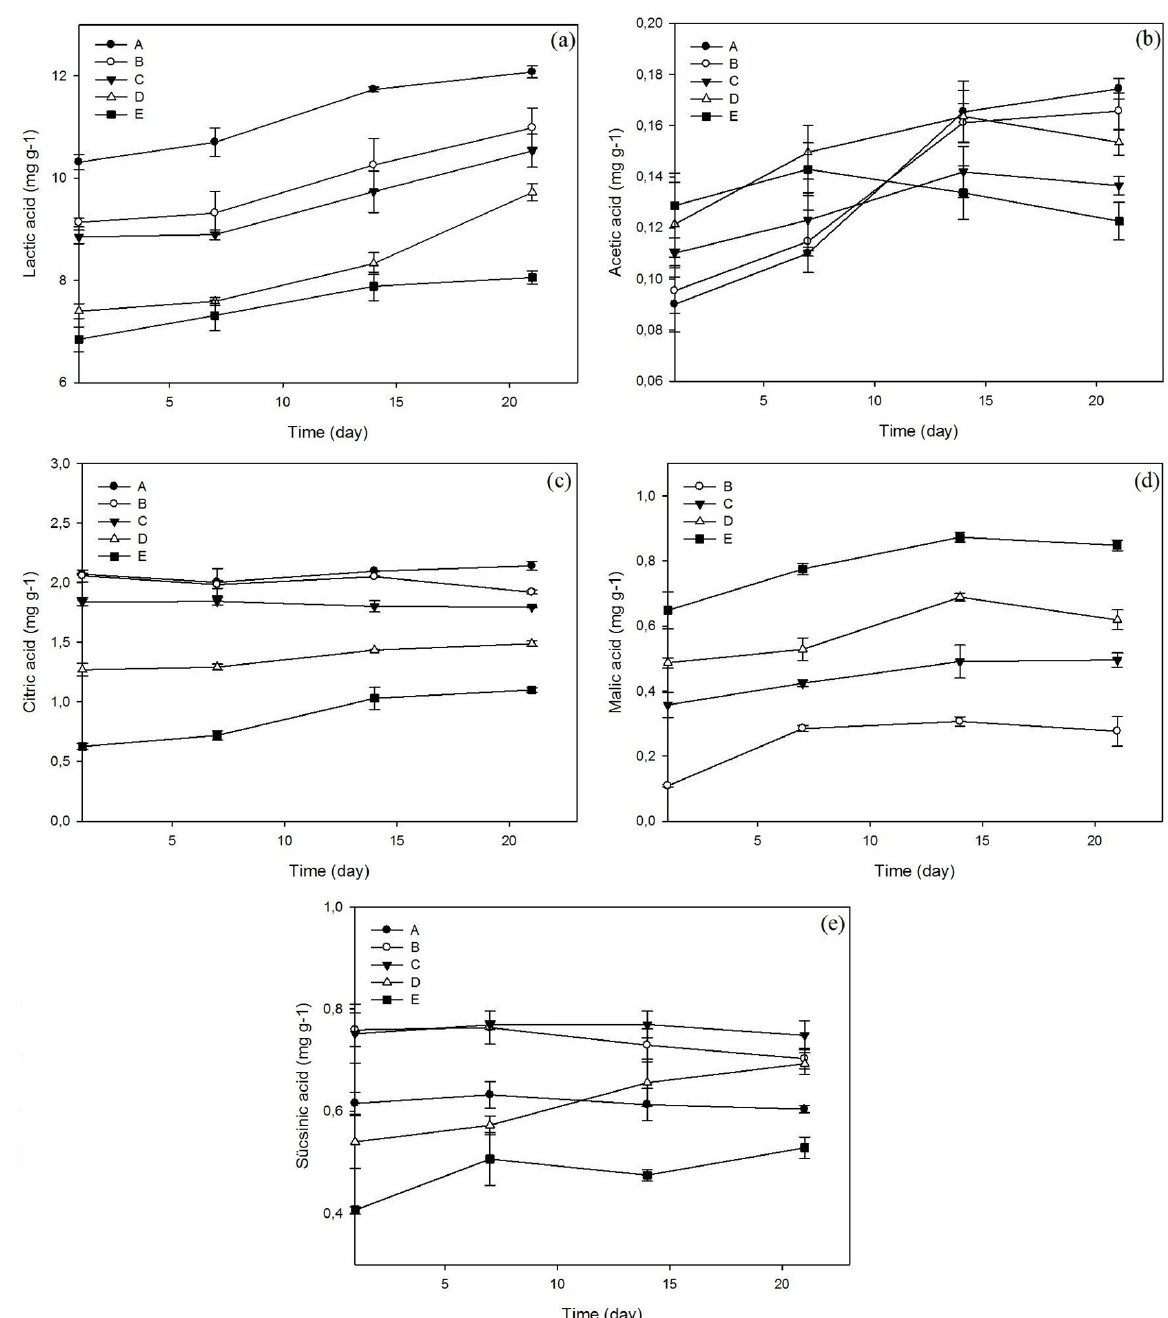
Figure 2. Organic acid profiles of yoghurt-like product produced with cow milk and hazelnut beverage during storage at 4 °C. (a) lactic acid, (b) acetic acid, (c) citric acid, (d) malic acid, (e) sücsinic